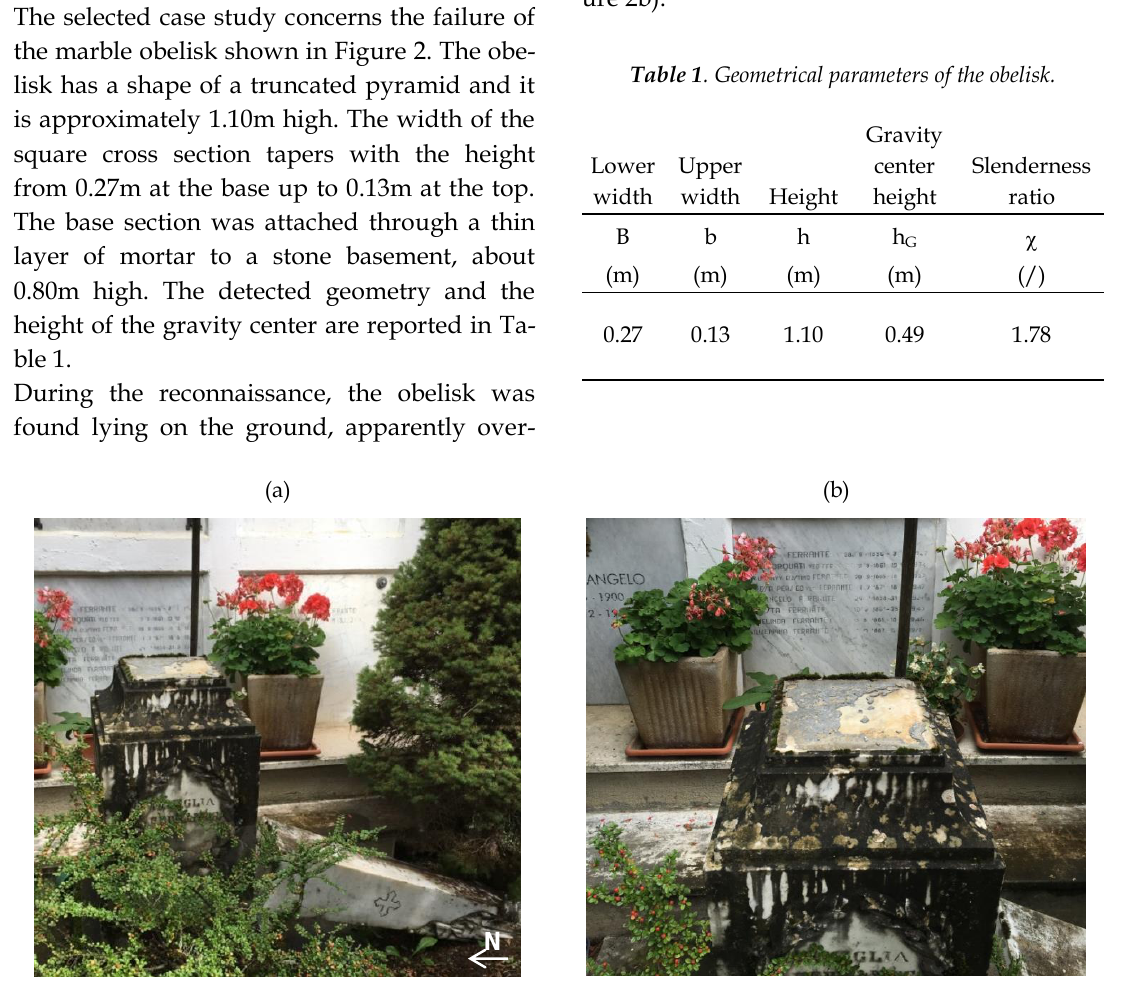
Figure 2 . Damaged obelisk in the Amatrice cemetery (a), particular of the base section